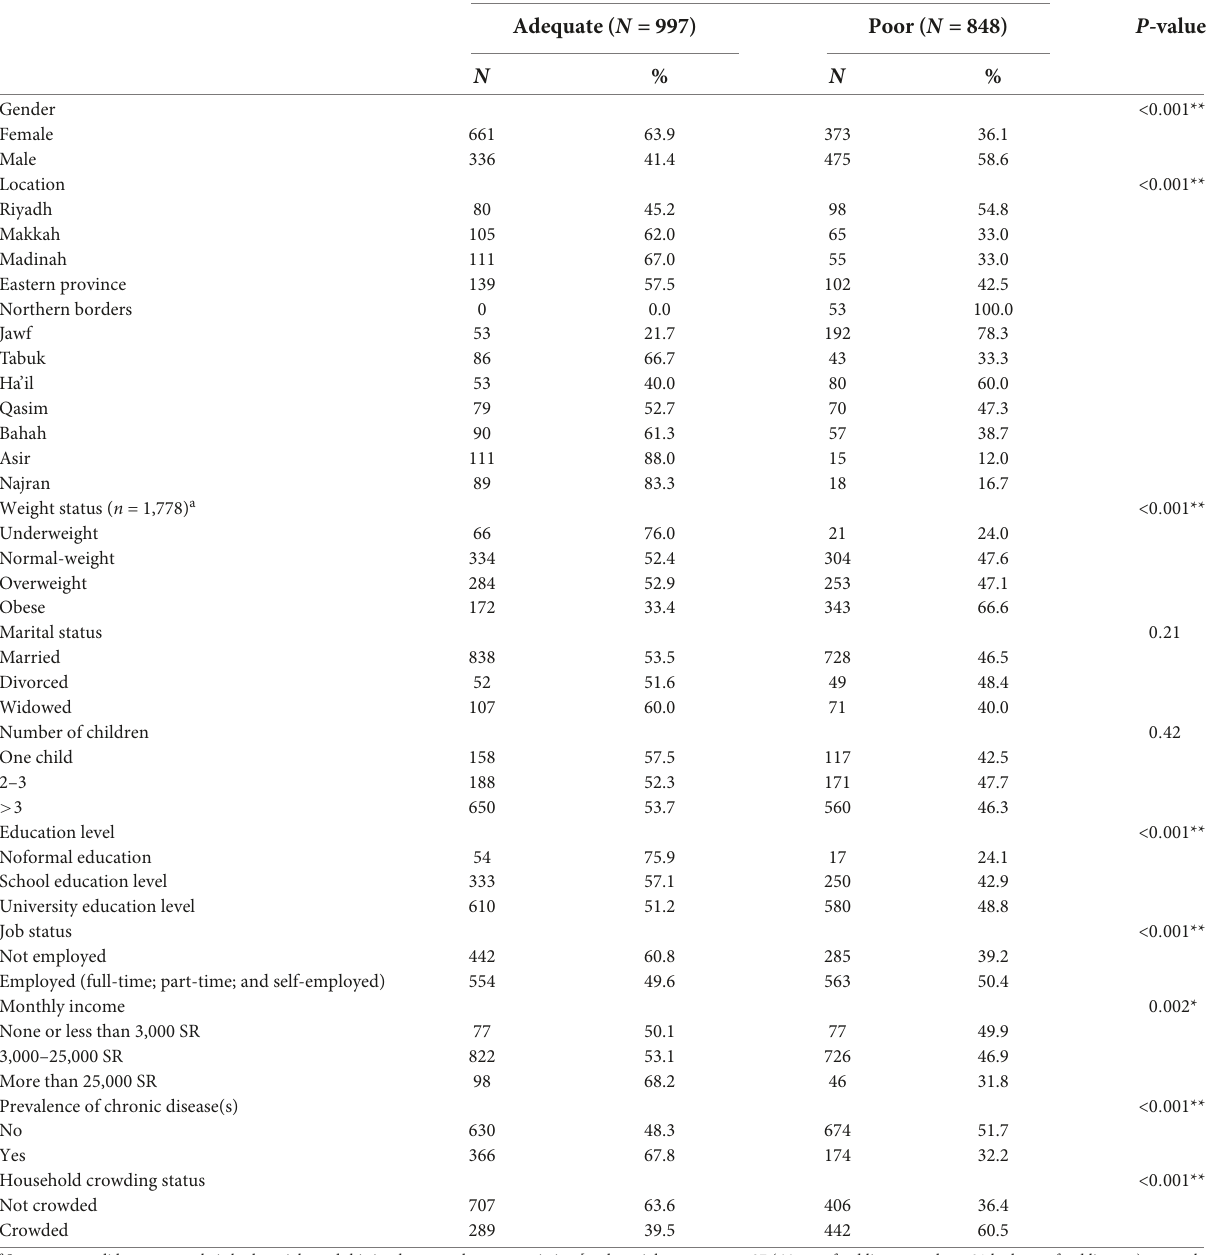
TABLE 3 The correlates associated with parental food literacy.